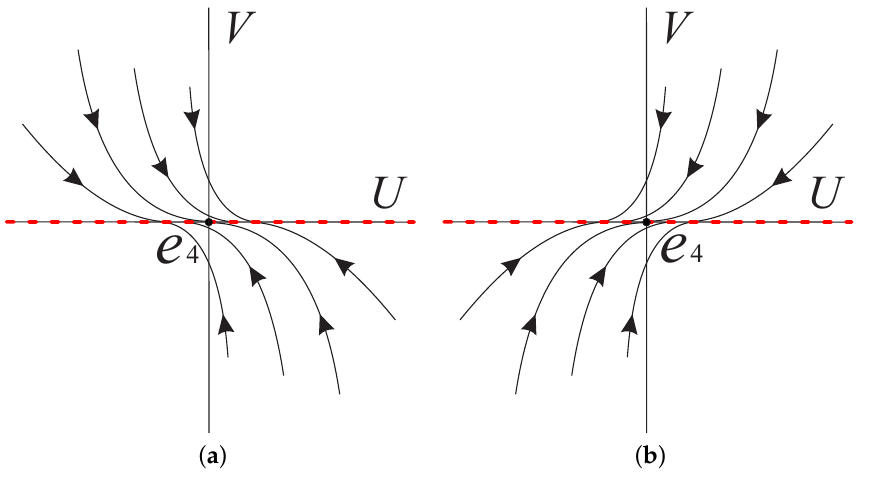
Figure 1. The local phase portrait at the equilibrium point e o = ( 0,0 ) of system (11) in ( a ) when s > 0, and in ( b ) when s <